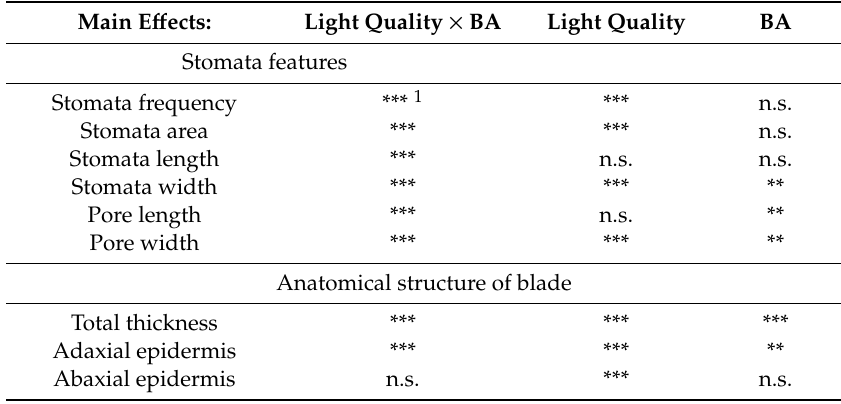
Table 1. Significant impact of light quality and 6-benzyladenine (BA) concentration in the medium and their interactions on the measured parameters of gerbera leaves grown in